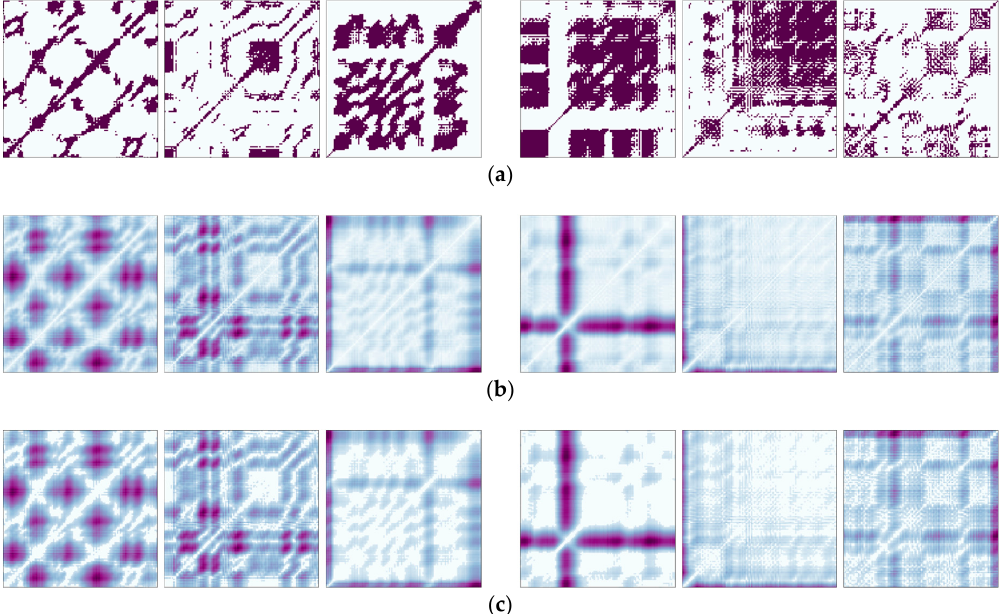
Figure 7. Three types of RPs produced from PPG signals (shown in Figure 6) at drowsy ( left ) and awake ( right ) states: ( a ) Bin-RP; ( b ) Cont-RP; ( c ) ReLU-RP.